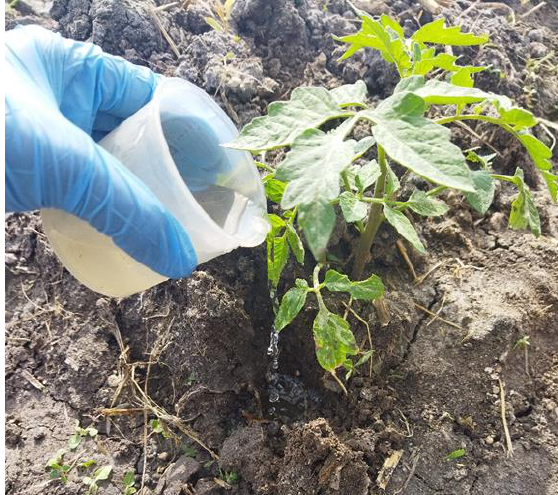
Figure 1. Soil drenching of Kendal Root biostimulant at 15 days after planting .